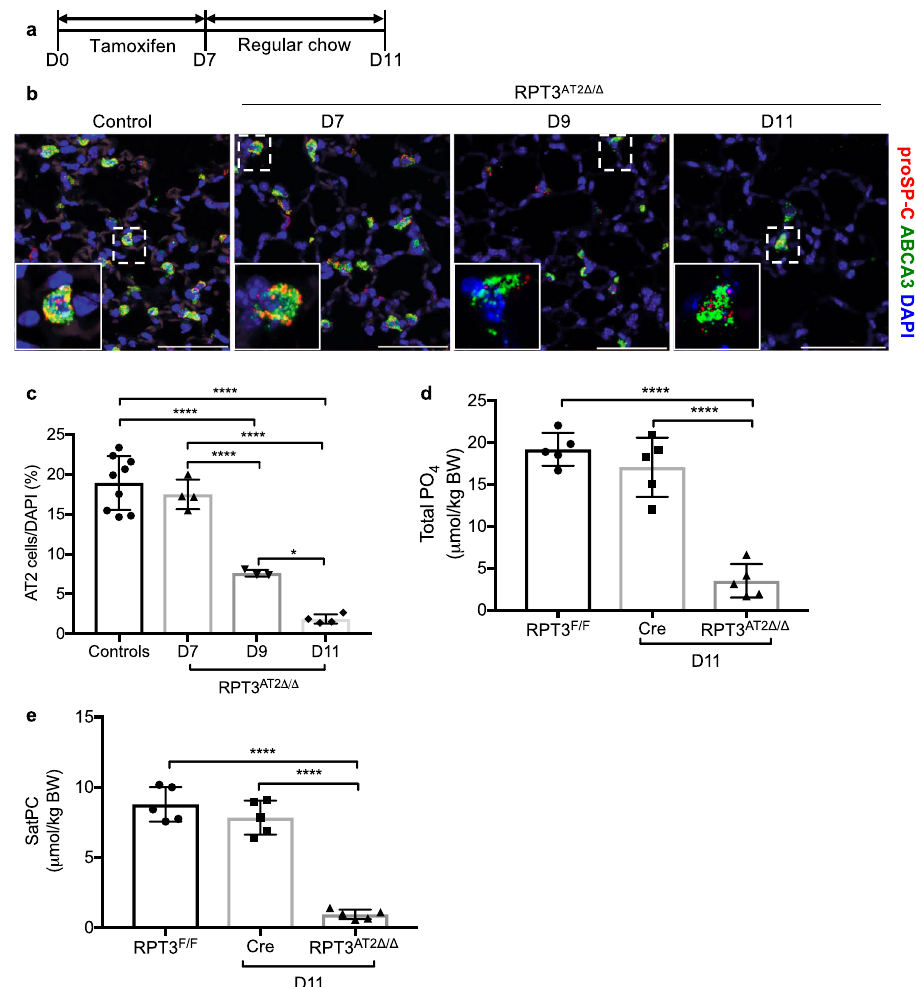
Figure 2. Targeted deletion of RPT3 in AT2 cells leads to AT2 cell loss. ( a ) Sftpc WT/CreER :RPT3 F/F and Sftpc WT/CreER (Cre) mice were fed tamoxifen chow for 7 days, then switched to regular chow on day 7. ( b ) Representative maximum intensity projections of confocal z-stacks of lung sections stained for proSP-C and ABCA3. Insets show proSP-C + ABCA3 + cell. Scale bars = 50 μ m. ( c ) Frequency of AT2 cells assessed by morphometric analysis of b. Controls included both RPT3 F/F mice ( Sftpc WT/CreER :RPT3 F/F mice without tamoxifen treatment) and Cre mice that were fed tamoxifen chow for 7 days. DAPI counts remained unchanged across all groups (not shown). ( d ) Concentration of total phosphate (PO 4 ) in bronchoalveolar lavage fluid (BALF), normalized to body weight (BW). ( e ) Concentration of saturated phosphatidylcholine (SatPC) in BALF, normalized to BW. Total PO 4 and SatPC were measured in mice euthanized on day 11. * p < 0.05, **** p < 0.0001 by one-way ANOVA with Tukey’s multiple comparison